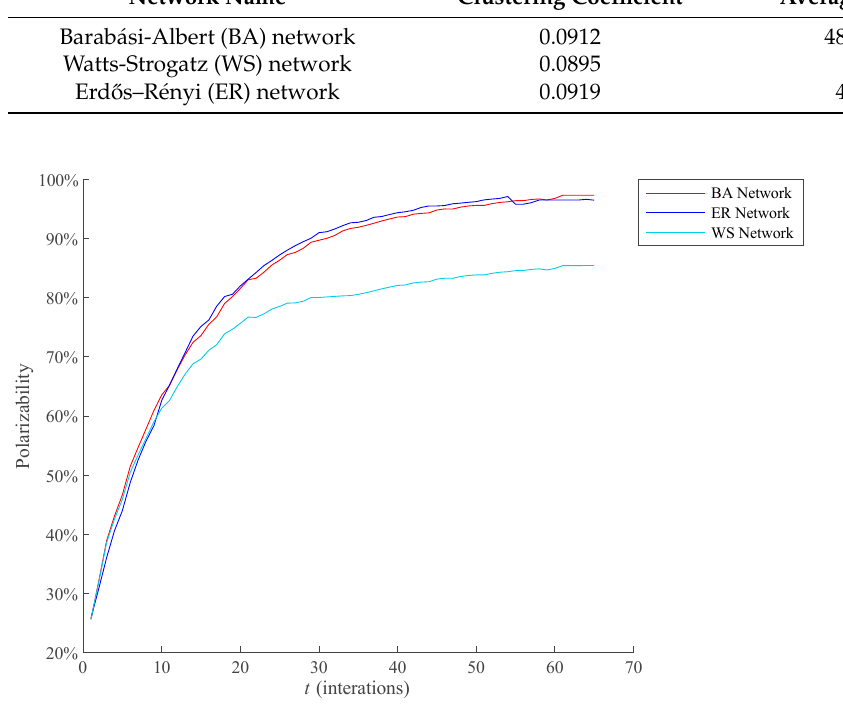
Figure 14. Comparison of polarizability of different